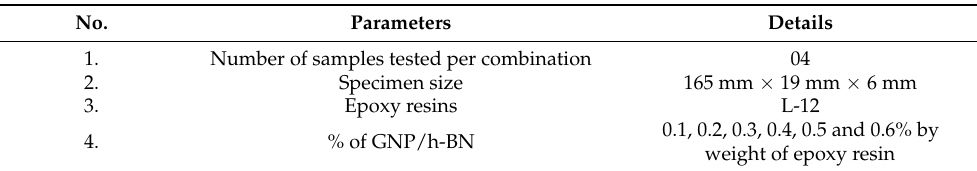
Table 4. Sample Characteristics